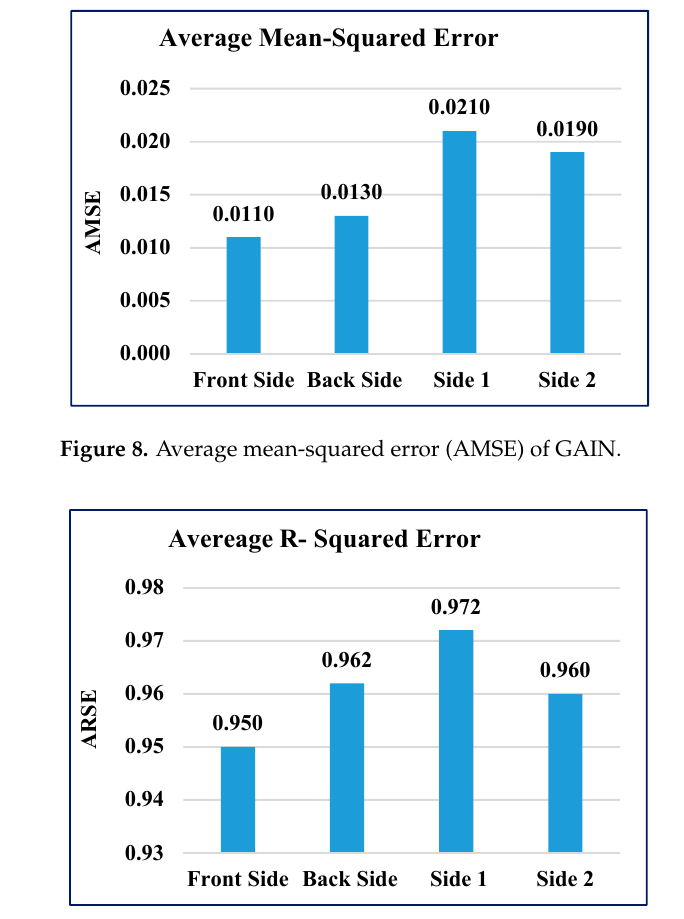
Figure 9. Average R-squared error (ARSE) of GAIN. Sensors 2021 , 21 , x FOR PEER REVIEW